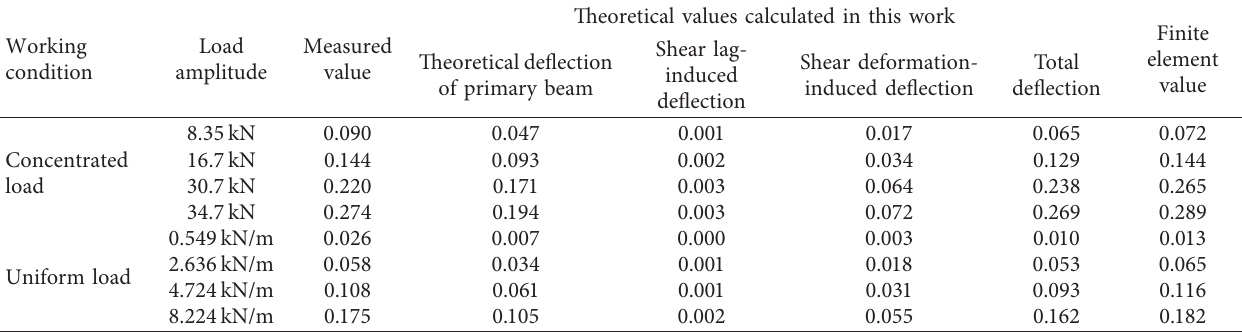
Table 2: Midspan deflections of the single box and single cell simply supported composite box girders with CSWSB (unit: mm). Working condition